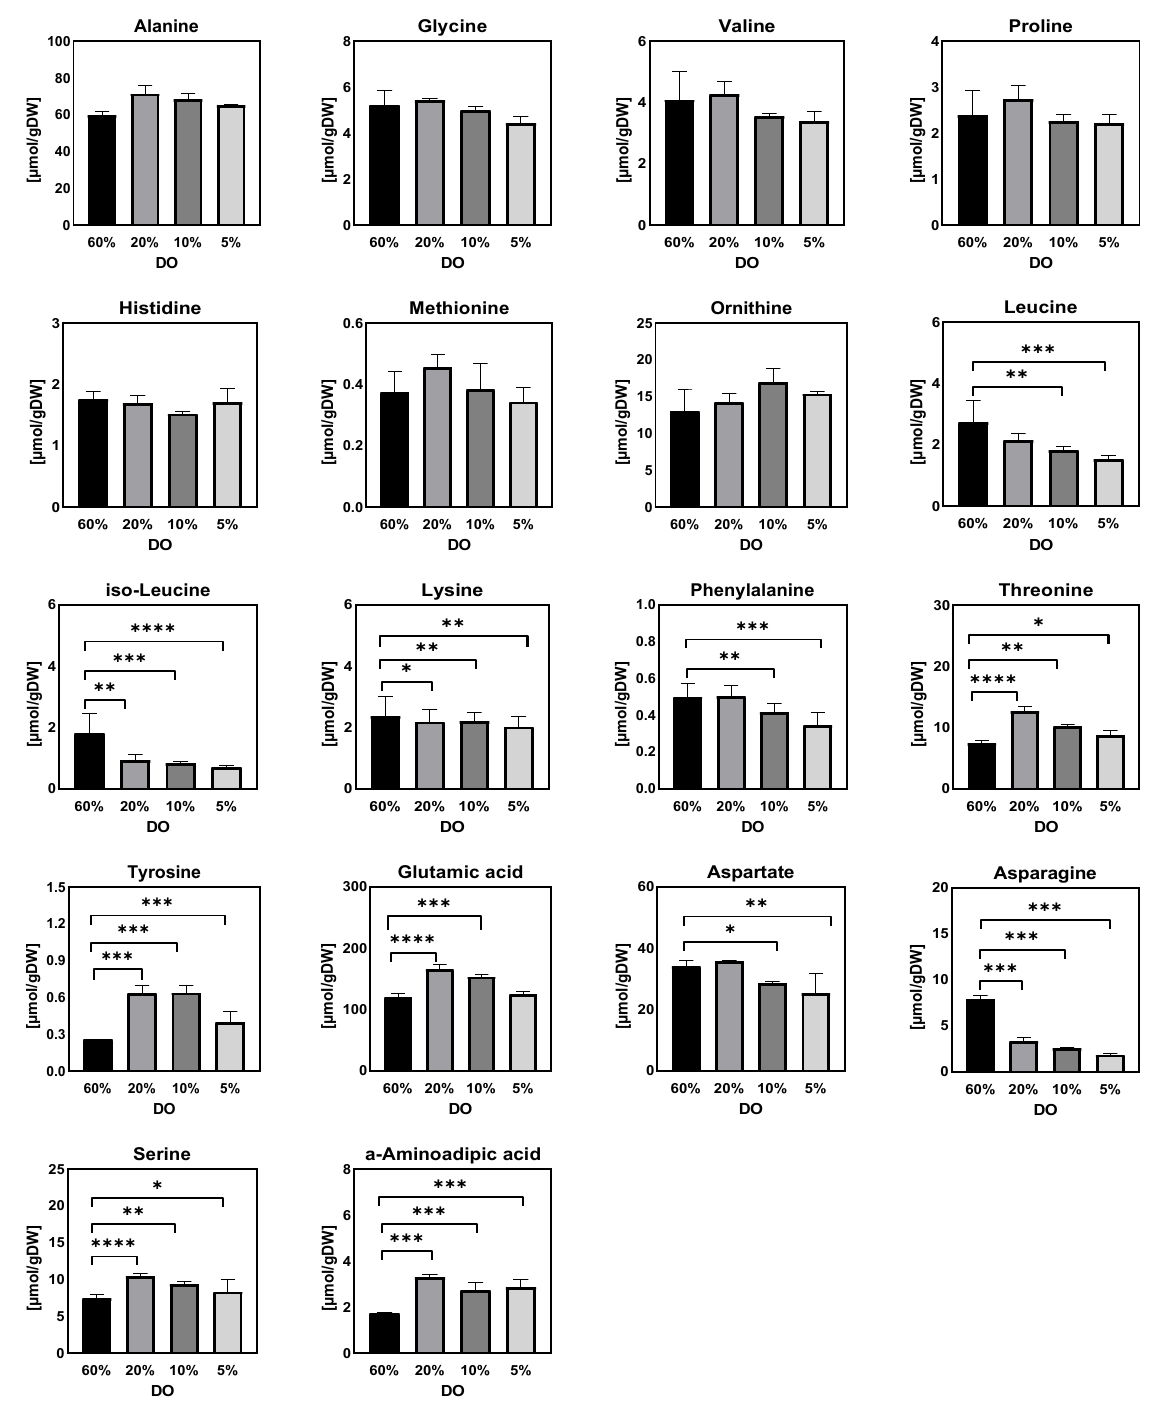
dissolved oxygen levels (Figure 3), partly because the amino acid pool was relatively large and has a long turnover time.